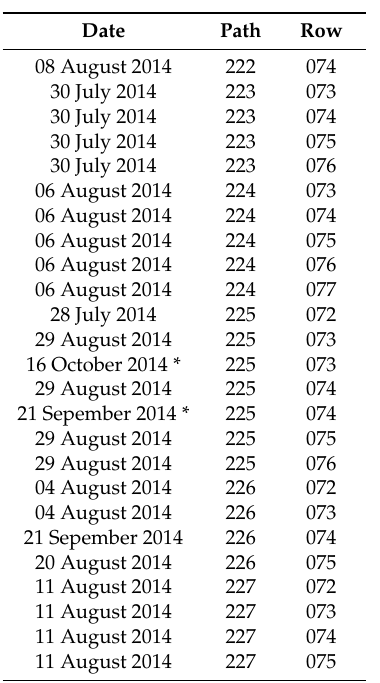
Table A1. Landsat 8 imagery